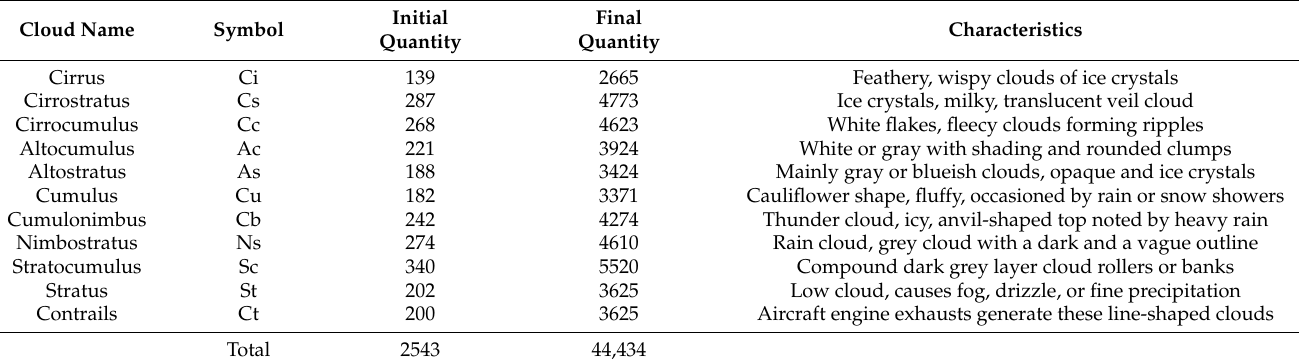
Table 1. Details of CCSN cloud